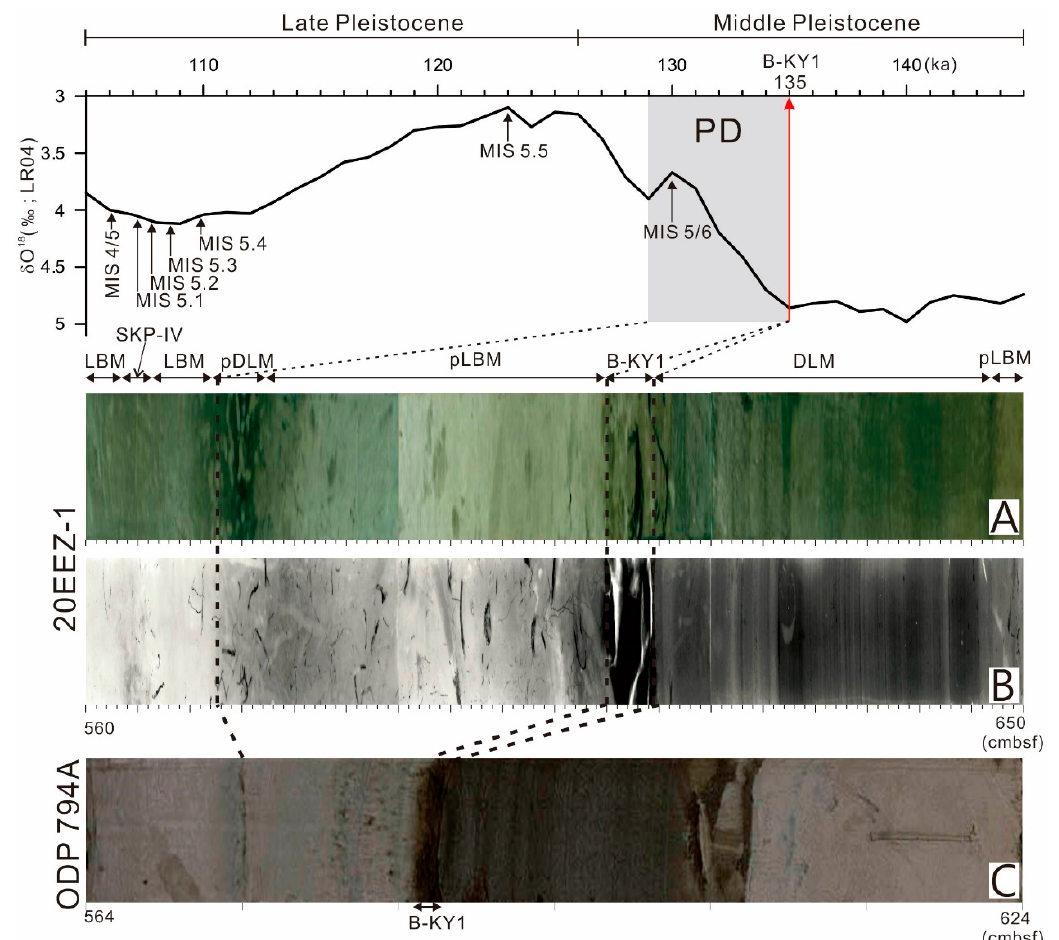
Figure 9. Improved eruption age estimate (ca. 135 ka) based on B-KY1 tephra and distinct sedimentary facies coinciding with the start of the penultimate deglaciation. ( A ) Photograph of the 20EEZ-1 core, ( B ): X-radiograph of the 20EEZ-1 core, ( C ): Photograph of ODP 794A core, MIS: Marine isotope stage, PD: Penultimate deglaciation, LBM: light bioturbated mud, DLM: dark bioturbated mud, cmbsf: cm below seafloor.